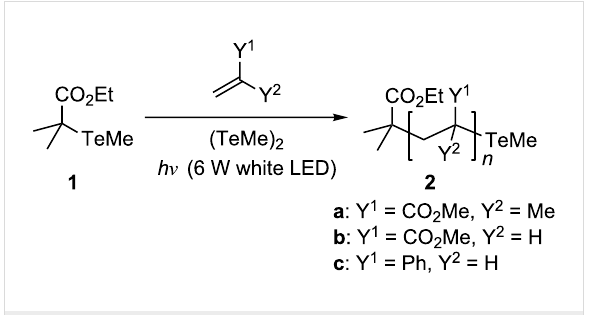
synthesis of block copolymers [30-34] and end-functional